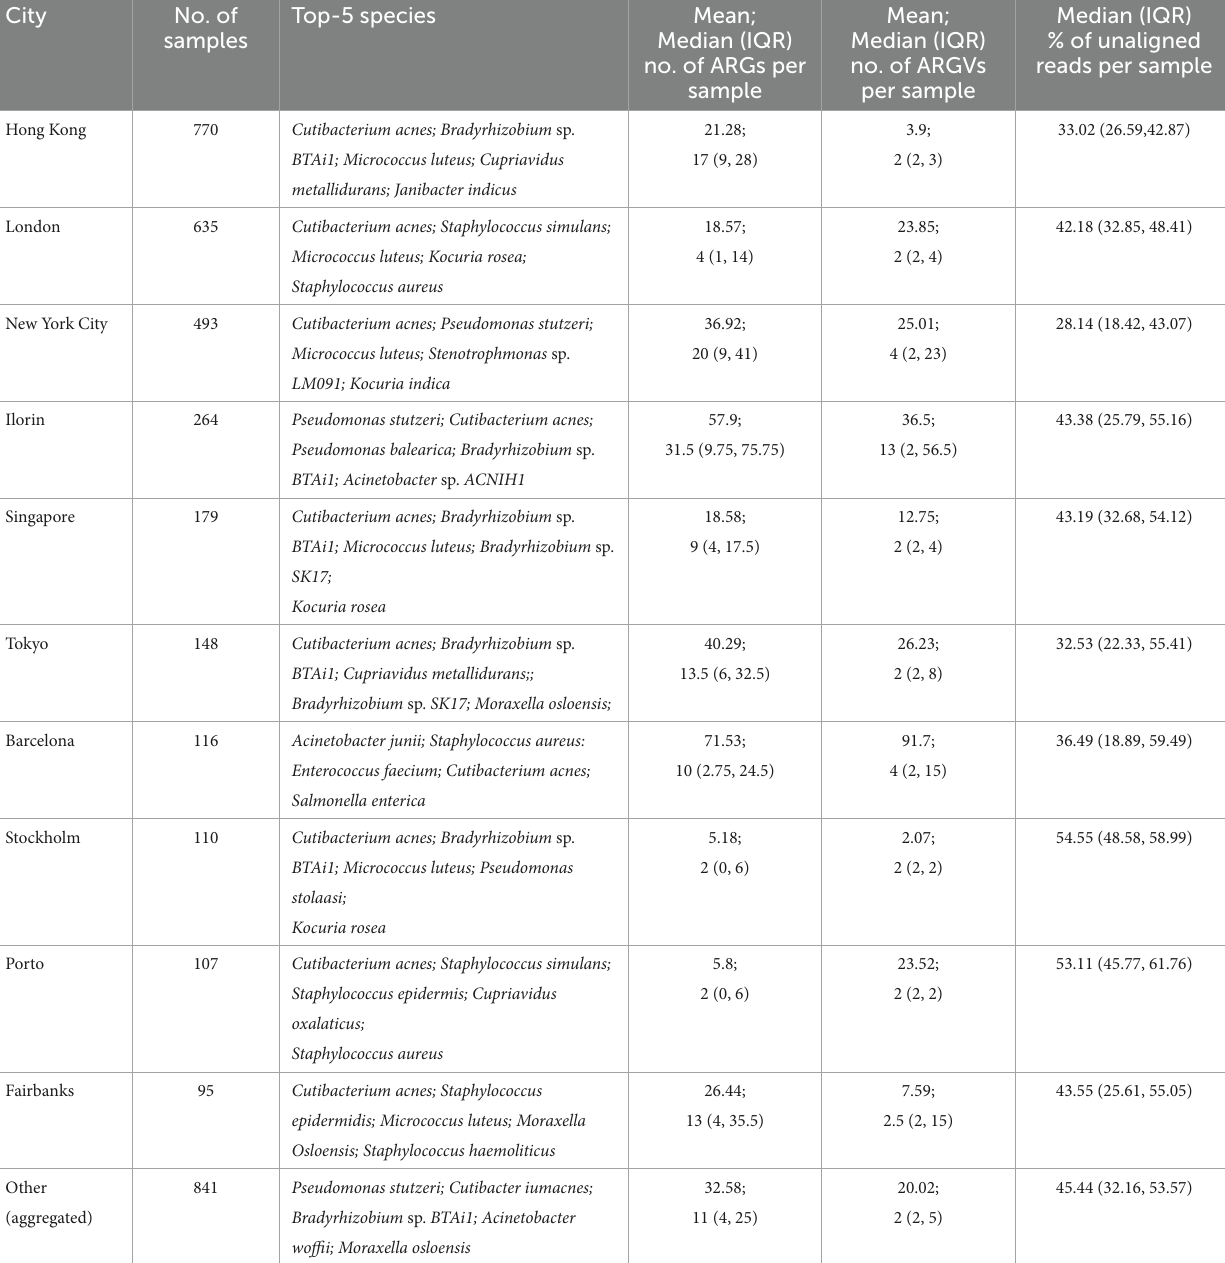
TABLE 1 Summary of MetaSUB study data stratified by city (top-10 by number of isolates, others aggregated). City No. of Top-5 species Mean; samples